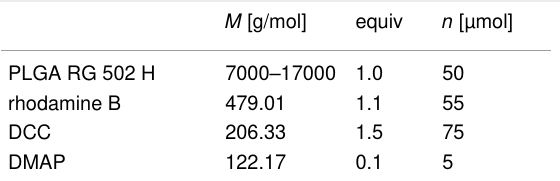
Table 2: Overview of the concentration of the different components used for